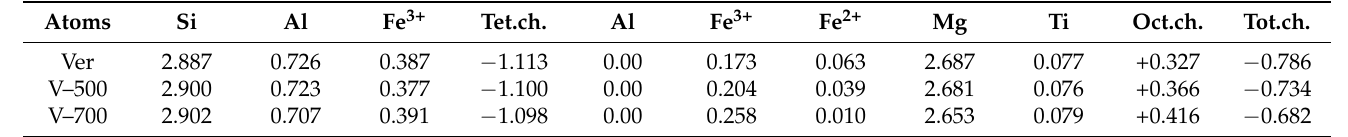
Table 2. Cations on the basis 22 − /O 10 (OH) 2 in vermiculite